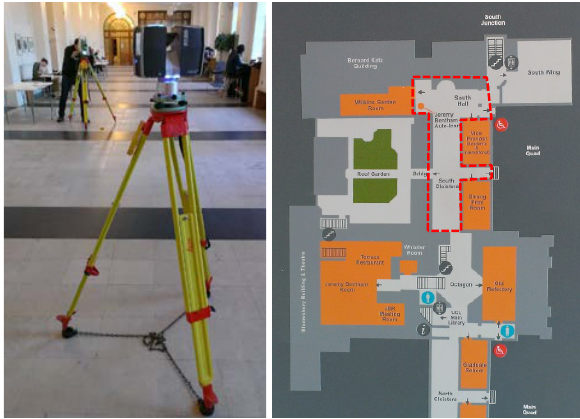
Figure 3: Control survey (left) and map (right) of the study